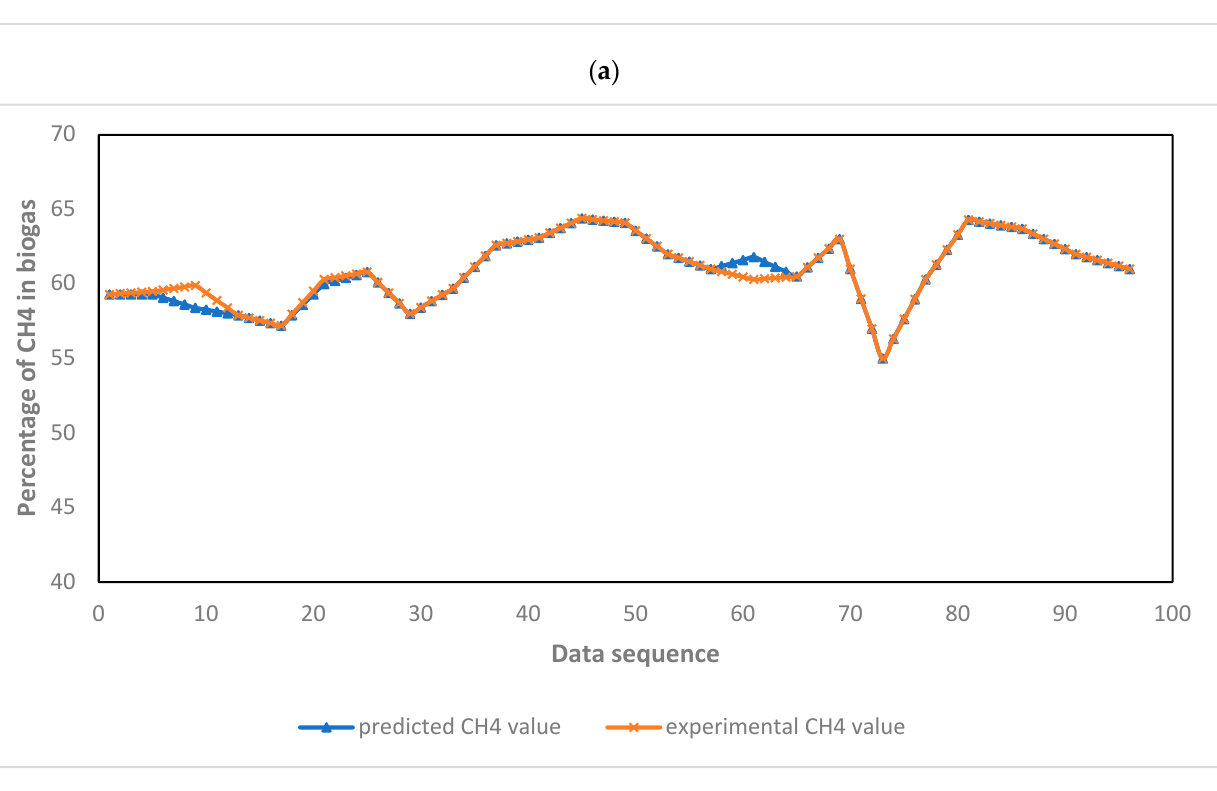
Figure 4. ( a ) Correlation between experimental data and predicted value of percentage of CH4 in